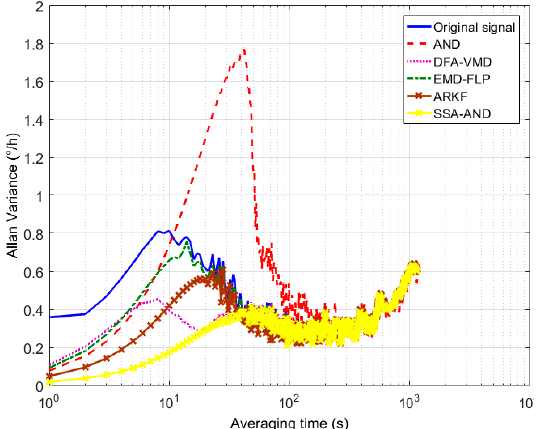
Figure 7. Allan variances analysis for FOG1.